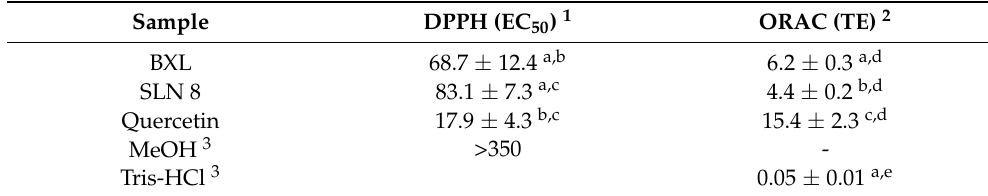
Table 4. Antioxidant activity determination of BXL and SLN8. EC 50 values refer to DPPH radical scavenging activity; TE values refer to ORAC